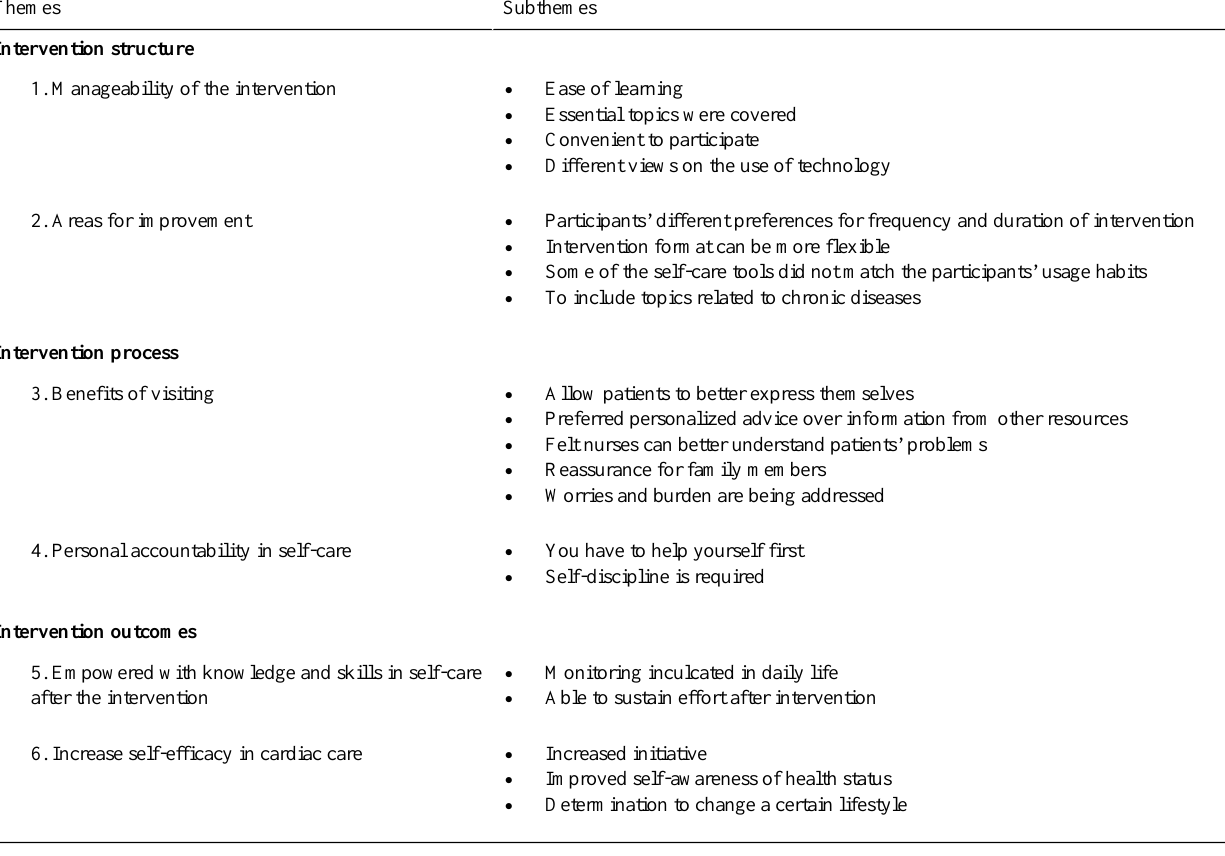
Table 2. Themes and